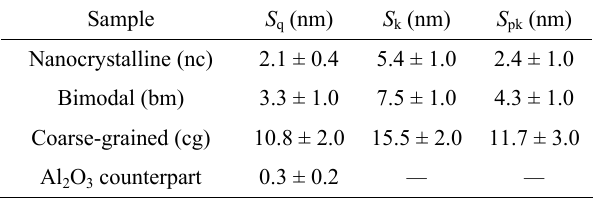
Table 3 Surface descriptive parameters of the evaluated microstructures and tribological